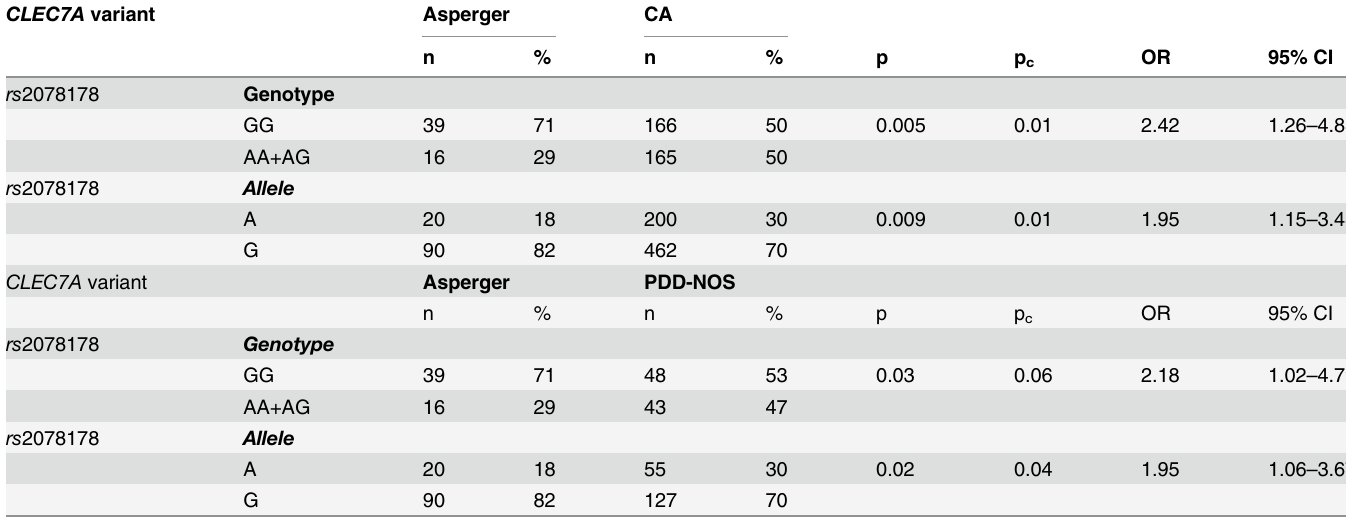
Table 4. CLEC7A alleles and genotypes distribution in patients with classical autism, Asperger and PDD-NOS. CLEC7A